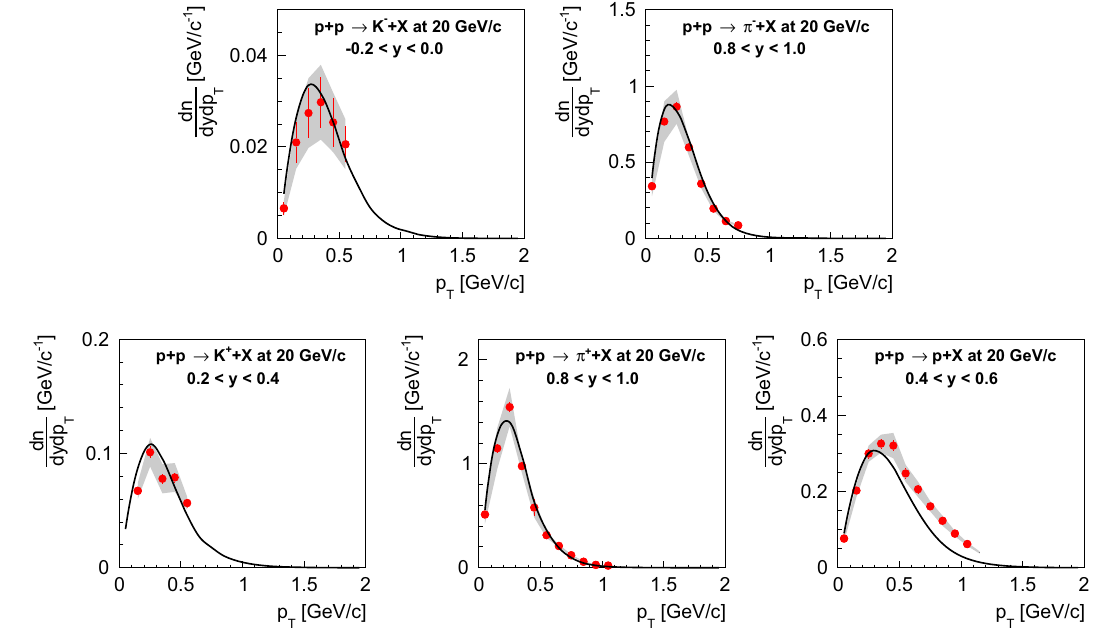
Fig. 23 Transverse momentum spectra of identified hadrons produced in inelastic p + p interactions at 20 GeV / c in selected rapidity intervals in comparison to the EPOS model [21] (black line). Systematic uncertainties are shown as shaded bands